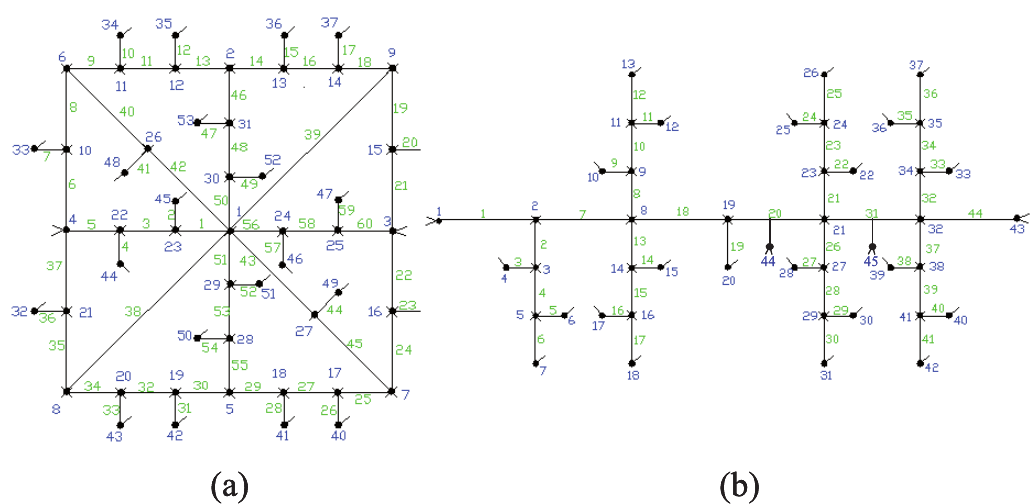
Fig. 4. Basic structure of the (a) compact and (b) linear buildings used in the experiments, indicating each of their nodes and edges. Exit nodes in compact case are number 3, 4, 8 and 9 (3 and 4 when only two exits), and in the linear case nodes 1, 43, 44 and 45 (1 and 43 when only two